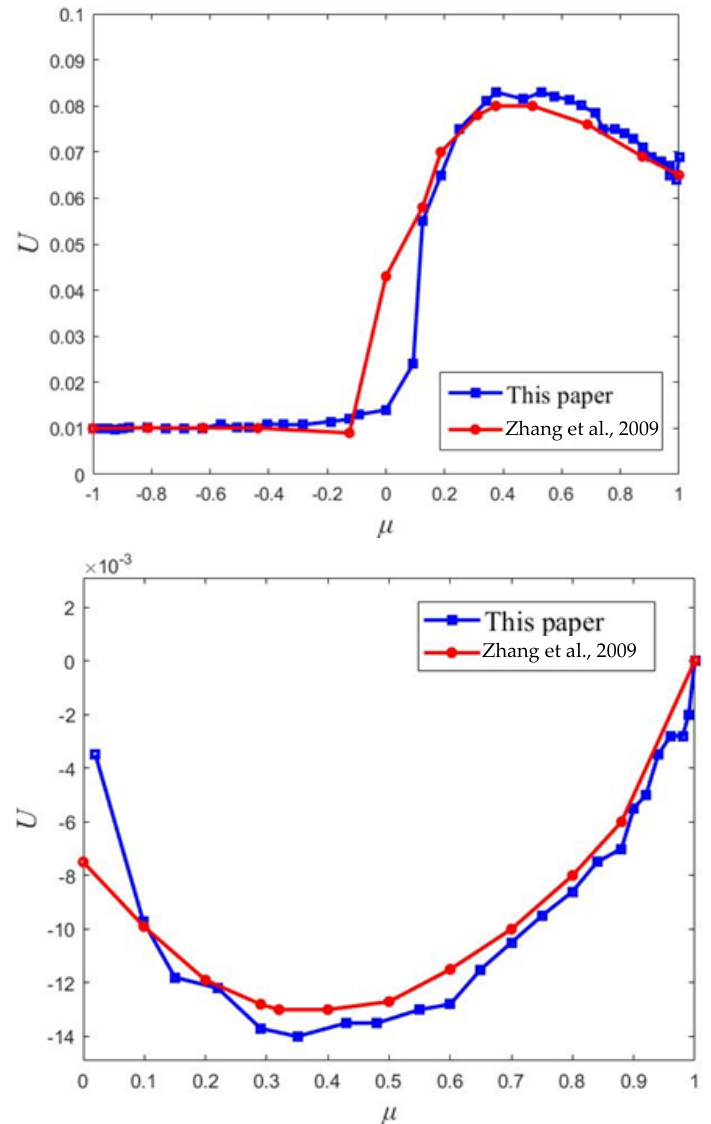
Figure 2. I and V component values in the 90° direction of the bottom circumferential angle of the atmosphere [16] .